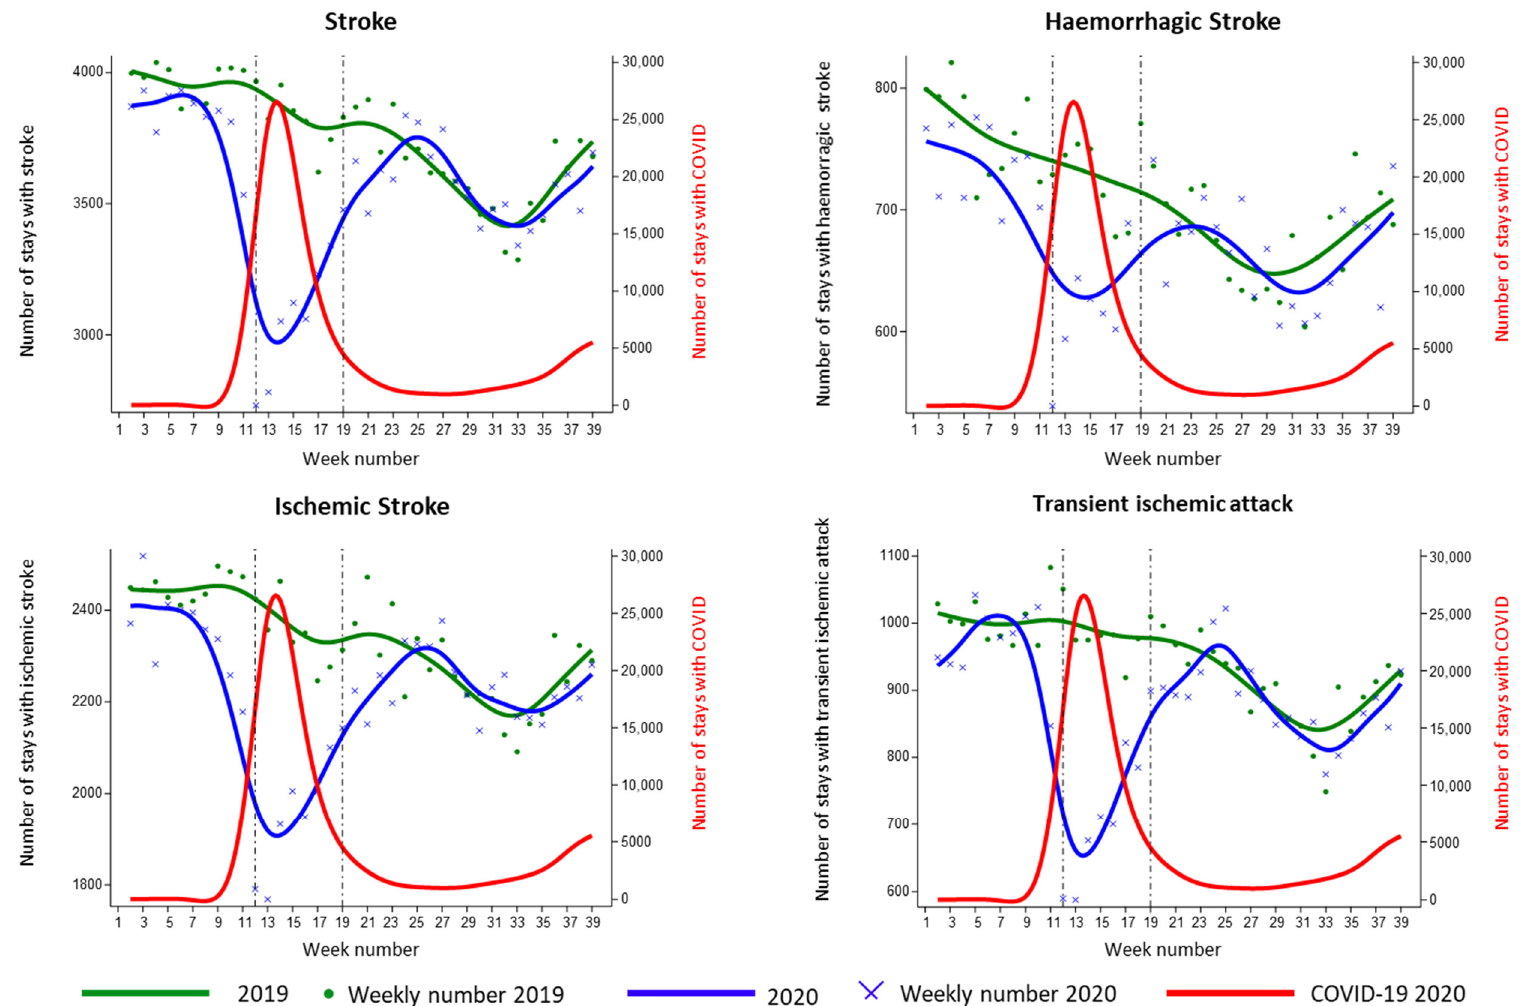
Figure 2. Hospital admissions for stroke and transient ischemic attacks in January to September 2020 versus 2019.